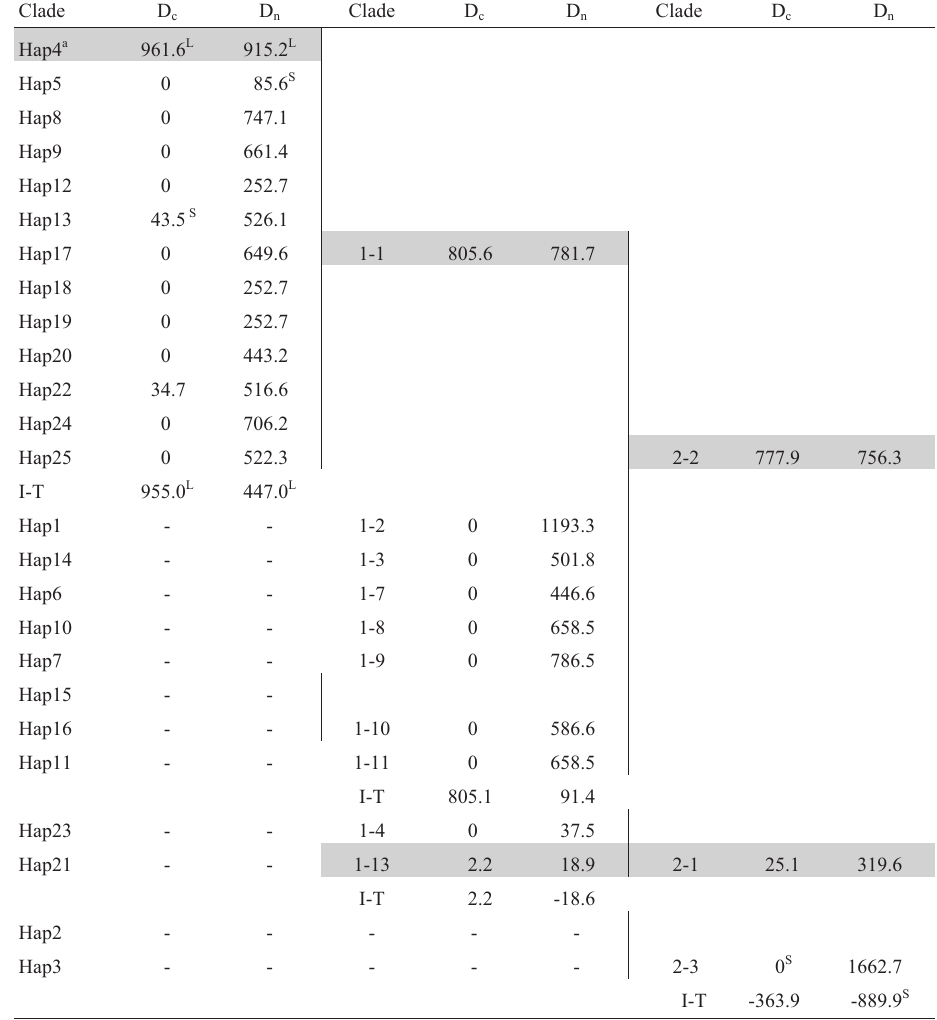
a Shading indicates internal haplotypes or clades, while clear indicates